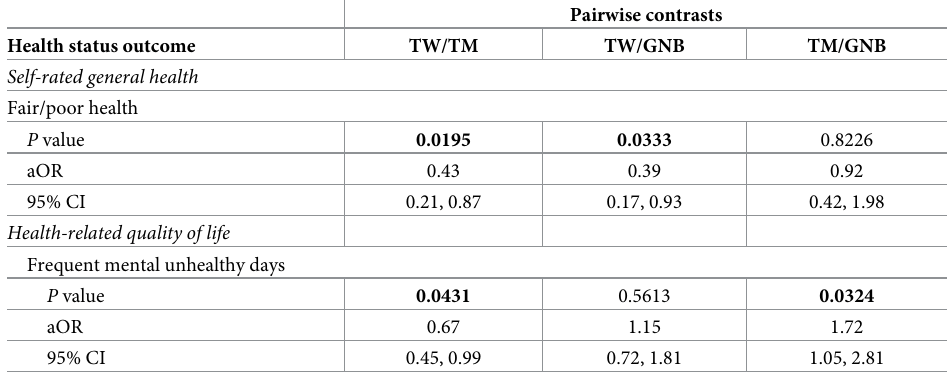
Table 6. Final multivariable model results: A posteriori contrasts for study group and health status outcomes.